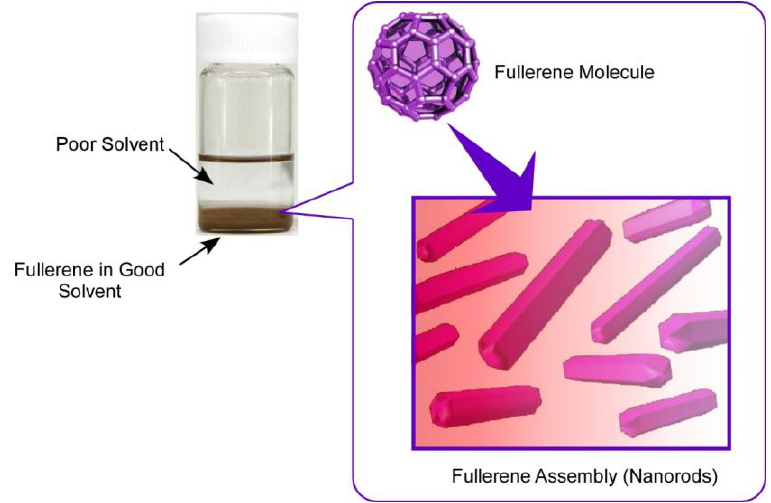
Figure 2. Liquid – liquid interfacial precipitation (LLIP) method for the fabrication of self-assembled structures with specific shapes.